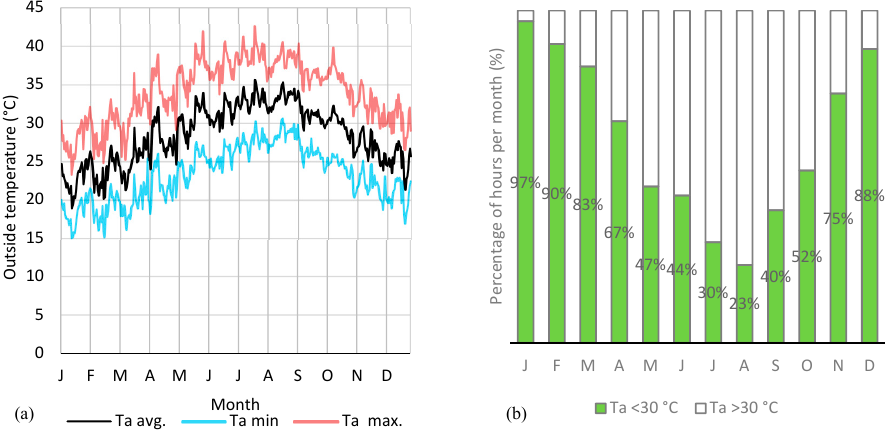
Figure 1. ( a ) Average monthly outside temperature (Ta); ( b ) window opening potential with respect to outside temperature.